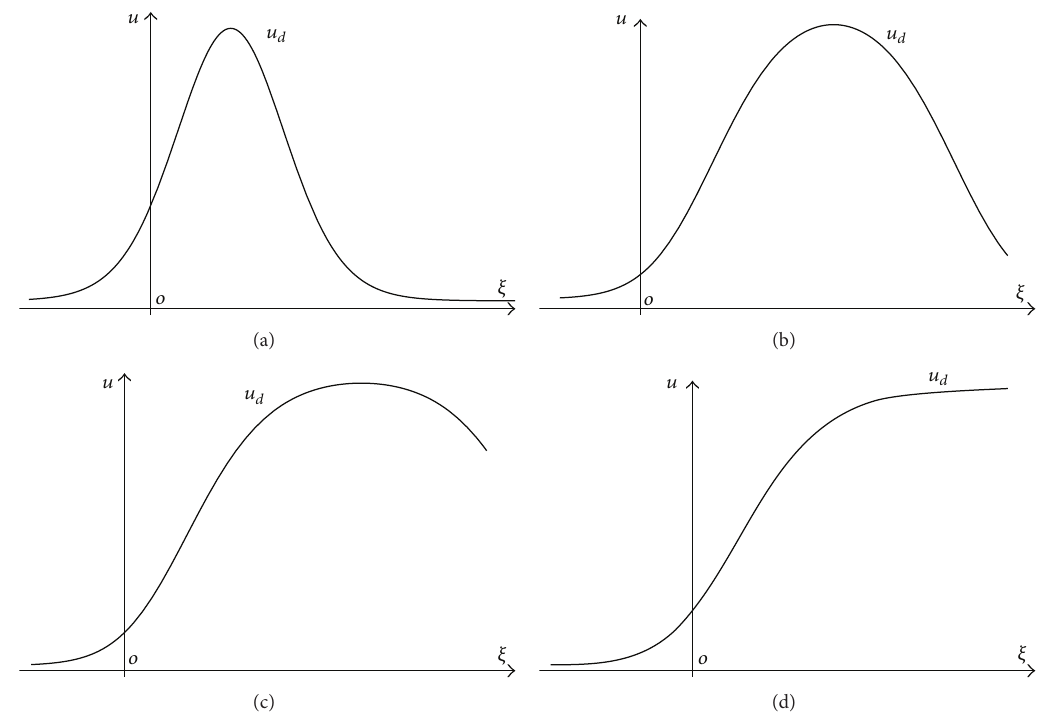
Figure 7: (The kink wave is bifurcated from the bell-shape solitary wave). The varying process for the graph of 𝑢 𝑑 when 𝑐 > 0 , 𝛿 > 0 , 𝑎 > 0 , 𝜆 > 0 and 𝑏 → −16𝑎 2 /75𝑐 + 0 . Where 𝑐 = 1 , 𝛿 = 1 , 𝑎 = 1 , 𝜆 = 50 and (a) 𝑏 = −16𝑎 2 /75𝑐 + 10 −1 . (b) 𝑏 = −16𝑎 2 /75𝑐 + 10 −3 . (c) 𝑏 = −16𝑎 2 /75𝑐 + 10 −4 . (d) 𝑏 = −16𝑎 2 /75𝑐 + 10 −7 .